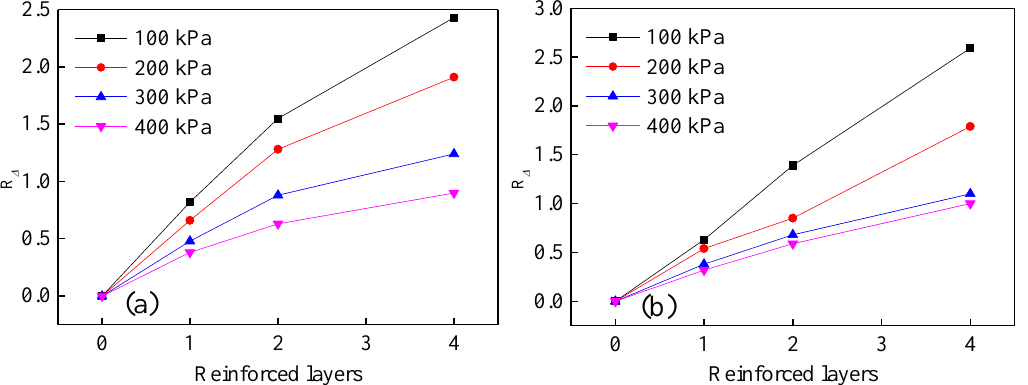
Figure 9. Variation in strength reinforcement effectiveness coefficient R σ under di ff erent reinforced layers: ( a ) Geogrids, ( b ) geotextiles.